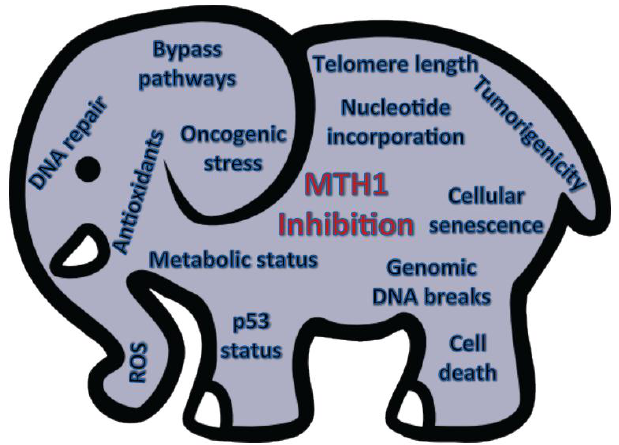
Figure 2. The elephant in the room. Schematic summarizing the molecular and cellular contexts that likely affect MTH1 inhibition-associated outcomes.